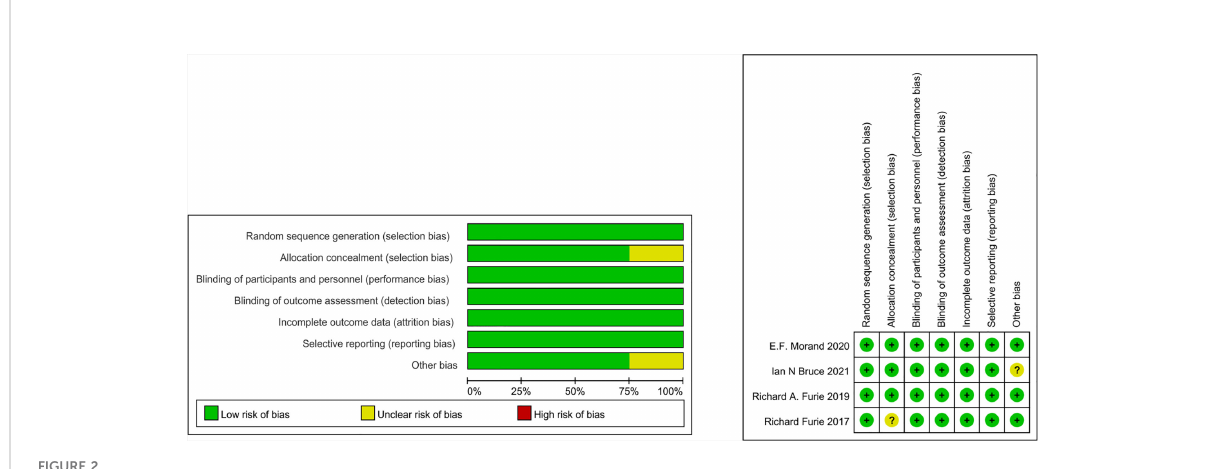
FIGURE 2 Summary of risk of bias of included